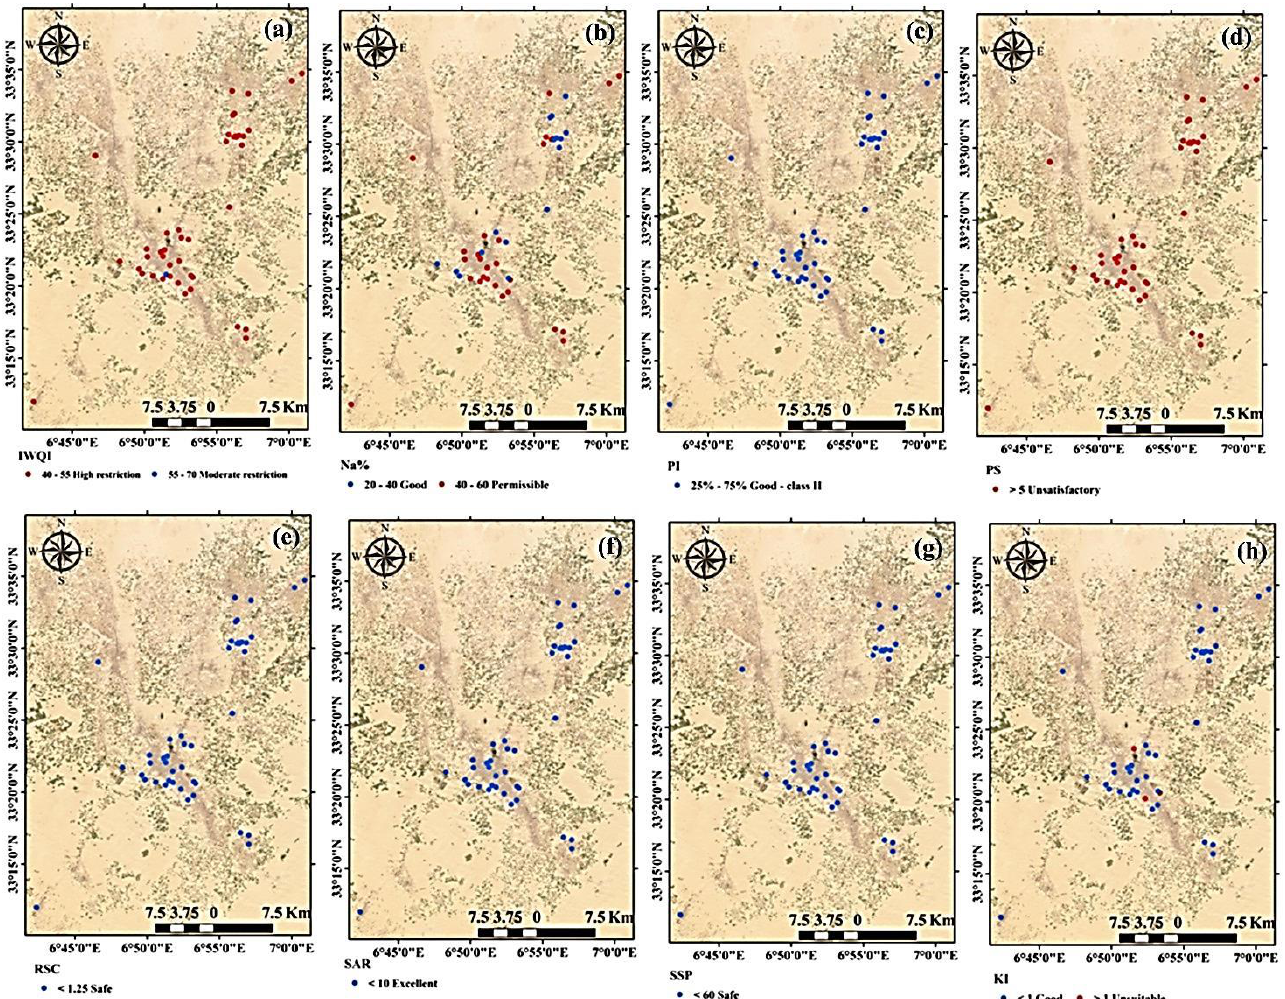
Figure 8. Spatial distribution maps of IWQIs in Souf Valley: ( a ) IWQI; ( b ) Na%; ( c ) SAR; ( d ) SSP; ( e ) KI; ( f ) PS; ( g ) PI; ( h ) RSC.